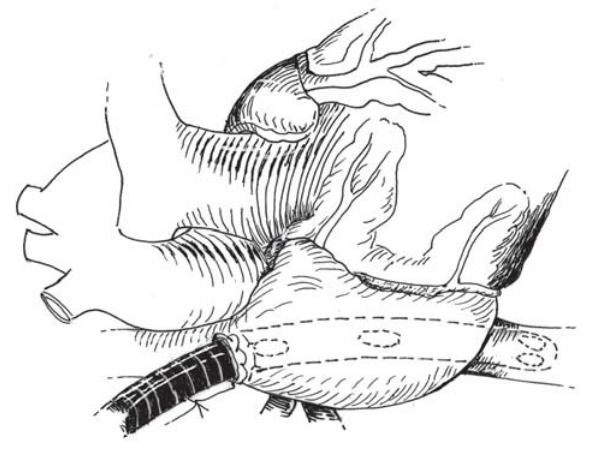
Fig 1. Uso de cânula de triplo estágio introduzida pela veia cava superior alcançando a veia cava